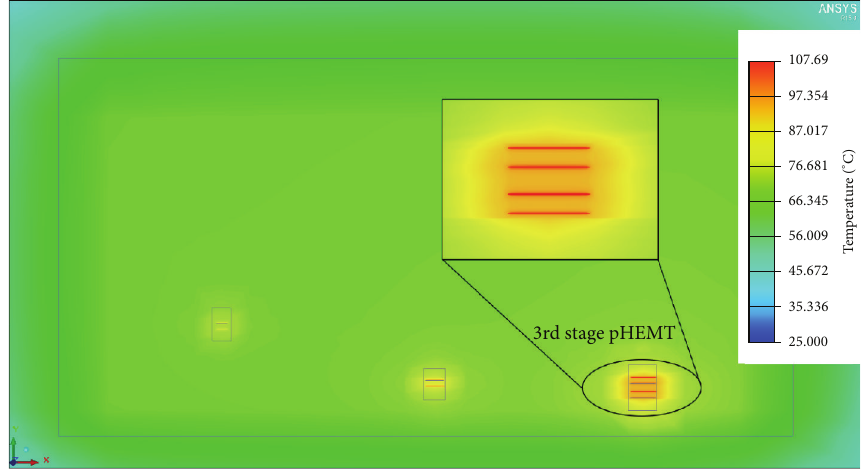
Figure 8: Thermal simulation of the PA with only three-pHEMT structure.